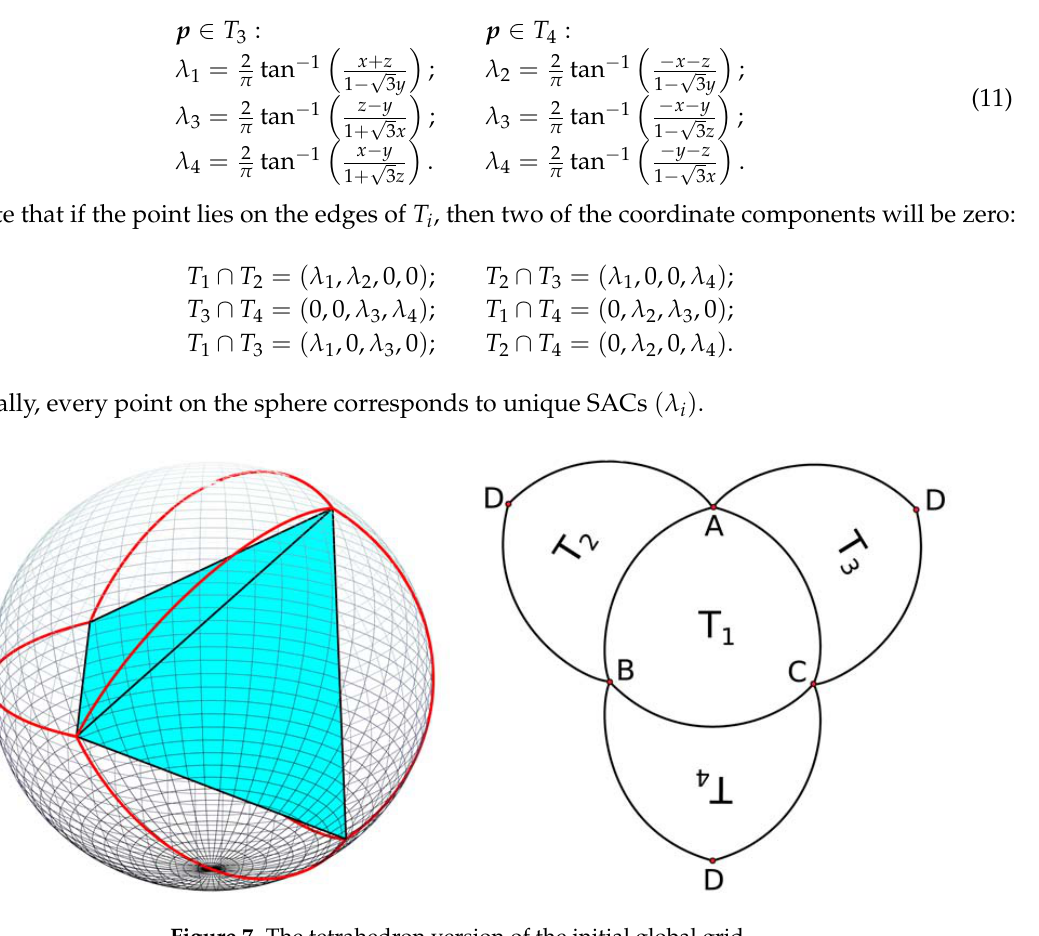
Figure 7. The tetrahedron version of the initial global